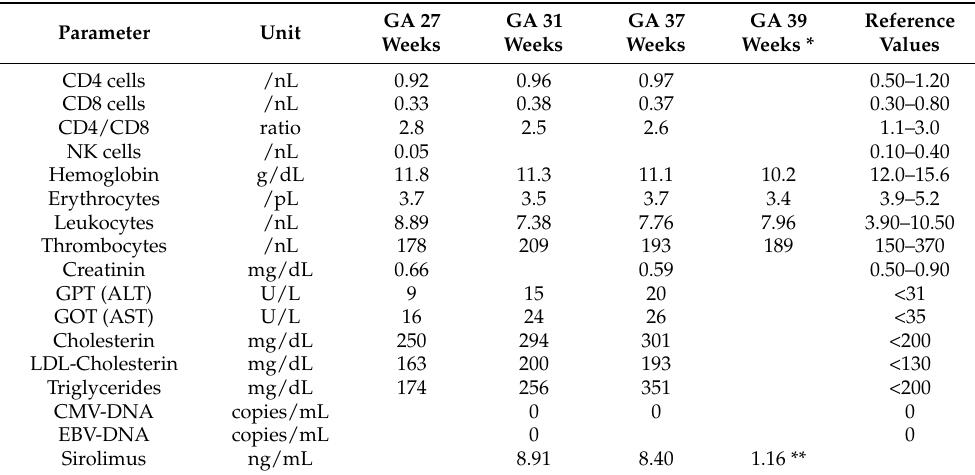
Table 1. Selected laboratory values of the mother. GA, gestational age; * at delivery; ** 8 days after terminating sirolimus treatment.